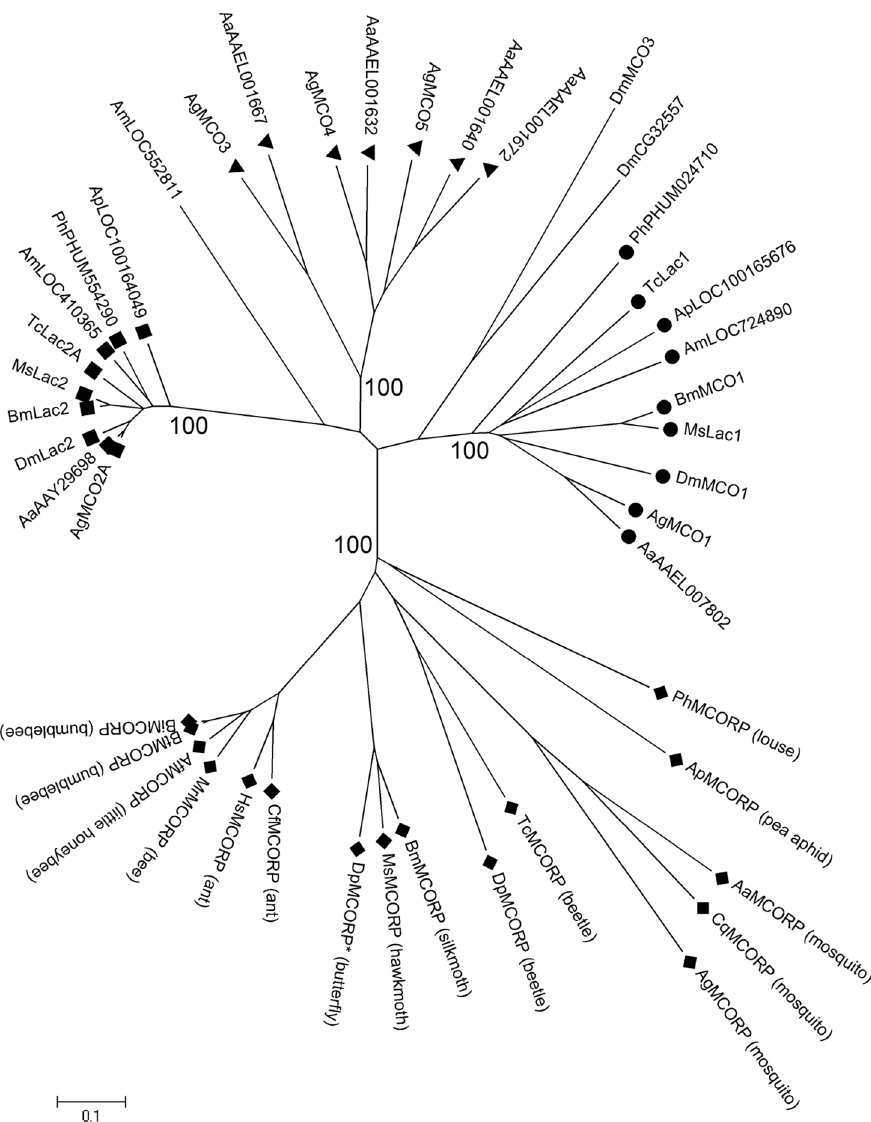
Figure 1. Phylogenetic tree of insect MCOs and MCORPs. The tree was constructed by the neighbor-joining method. Numbers shown are bootstrap values expressed as a percentage. Bootstrap values are only shown for the MCORP branch (diamond), MCO1 branch (circle), MCO2 branch (square), and the mosquito-specific branch (triangle). All identified MCORPs were included in the analysis, and MCOs from insect species that represent different insect orders were included, Abbreviations used are: Ag, Anopheles gambiae ; Aa, Aedes aegypti ; Cq, Culex quinquefasciatus ; Tc, Tribolium castaneum ; Dp, Dendroctonus ponderosae ; Ms, Manduca sexta ; Bm, Bombyx mori ; Dp*, Danaus plexippus ; Cf, Camponotus floridanus ; Hs, Harpegnathos saltator ; Bt, Bombus terrestris ; Bi, Bombus impatiens ; Mr, Megachile rotundata ; Af, Apis florae ; Ap, Acyrthosiphon pisum ; Ph, Pediculus humanus corporis ; Dm, Drosophila melanogaster ; Am, Apis mellifera . Accession numbers are listed in Table S2.